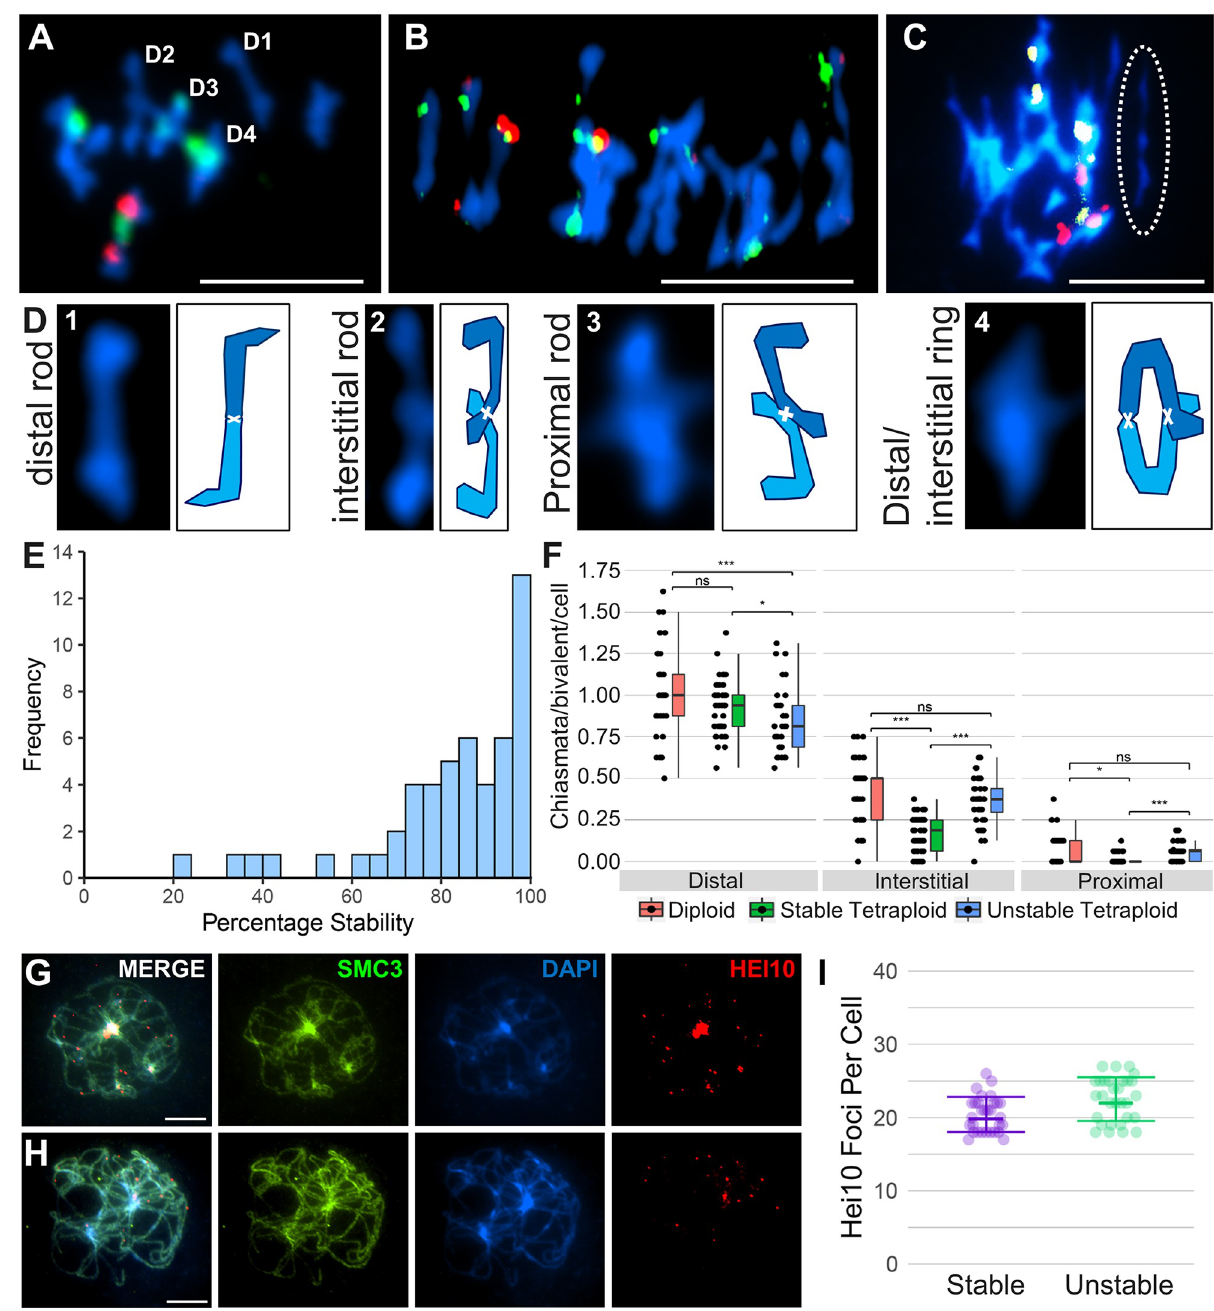
Fig 2. Cytological analysis of meiotic metaphase I stability, chiasma frequency and distribution. (A) Diploid A . lyrata bivalents stained with DAPI (blue) 5 S rDNA (red) and 45 S rDNA (green). (B) Stable autotetraploid meiotic metaphase I, stained with DAPI (blue) 5 S rDNA (red) and 45 S rDNA (green). (C) Unstable autotetraploid meiotic metaphase I, stained with DAPI (blue) 5 S rDNA (red) and 45 S rDNA (green) exhibiting one multivalent and one bivalent highlighted by the ellipse with white dashes that can be scored. (D) Four bivalents from A, with diagrammatic representations of homologous chromosomes in different shades of blue physically linked by chiasmata, shown by white crosses. (E) Histogram of the frequency of meiotic stability in individual plants from all populations. (F) Comparison of chiasmata position and frequency of A . lyrata bivalents from diploid (red), stable tetraploid (green) and, unstable tetraploid (blue). (G) Representative image of HEI10 foci at late pachytene in a stable nucleus, immunolocalised with SMC3 and counterstained with DAPI. (H) Representative image of HEI10 foci at late pachytene in an unstable nucleus, immunolocalised with SMC3 and counterstained with DAPI. (I) HEI10 counts from stable and unstable pachytene nuclei. Bars for A-C, G and H = 10 μ m.